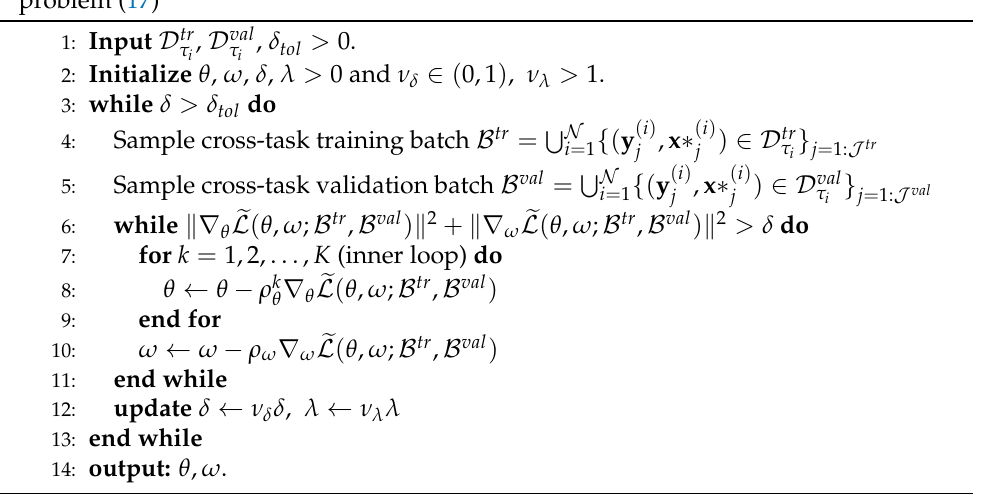
Algorithm 2: Stochastic mini-batch alternating direction penalty method to solve problem